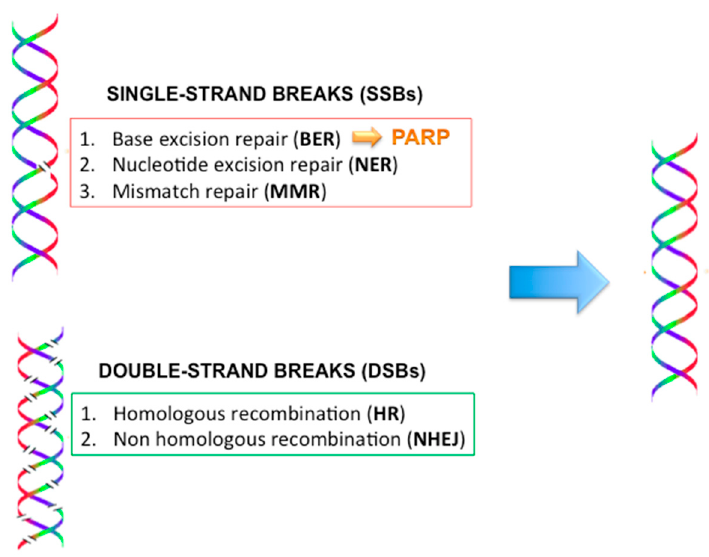
Figure 4. DNA repair mechanisms and the role of PARP enzymes. PARP: Poly (ADP-ribose) polymerase.